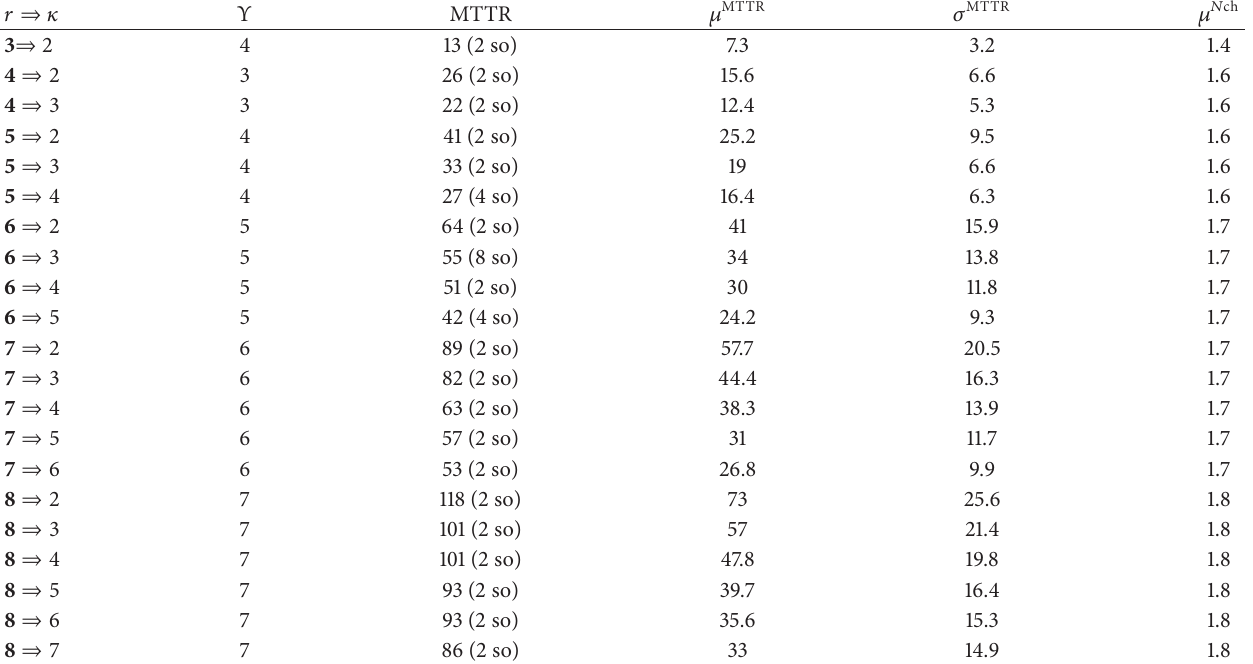
Table 4: MtQS-DSrdv: maximum time-to-RDV performance of 𝜅 .